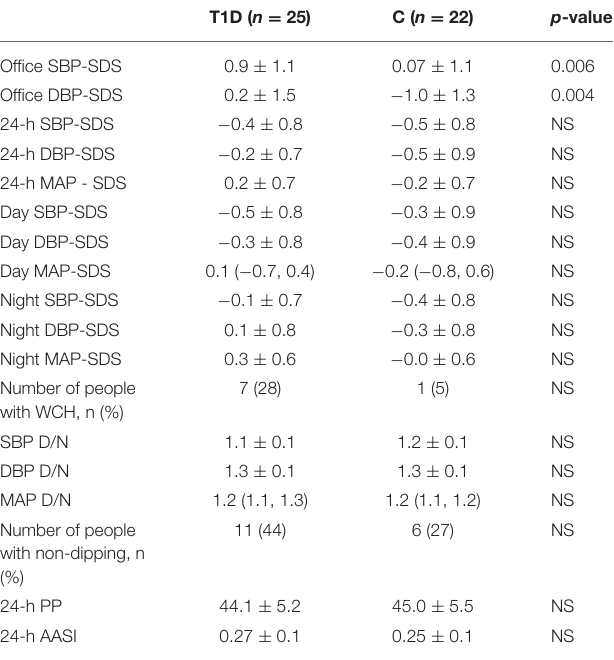
TABLE 2 | Blood pressure